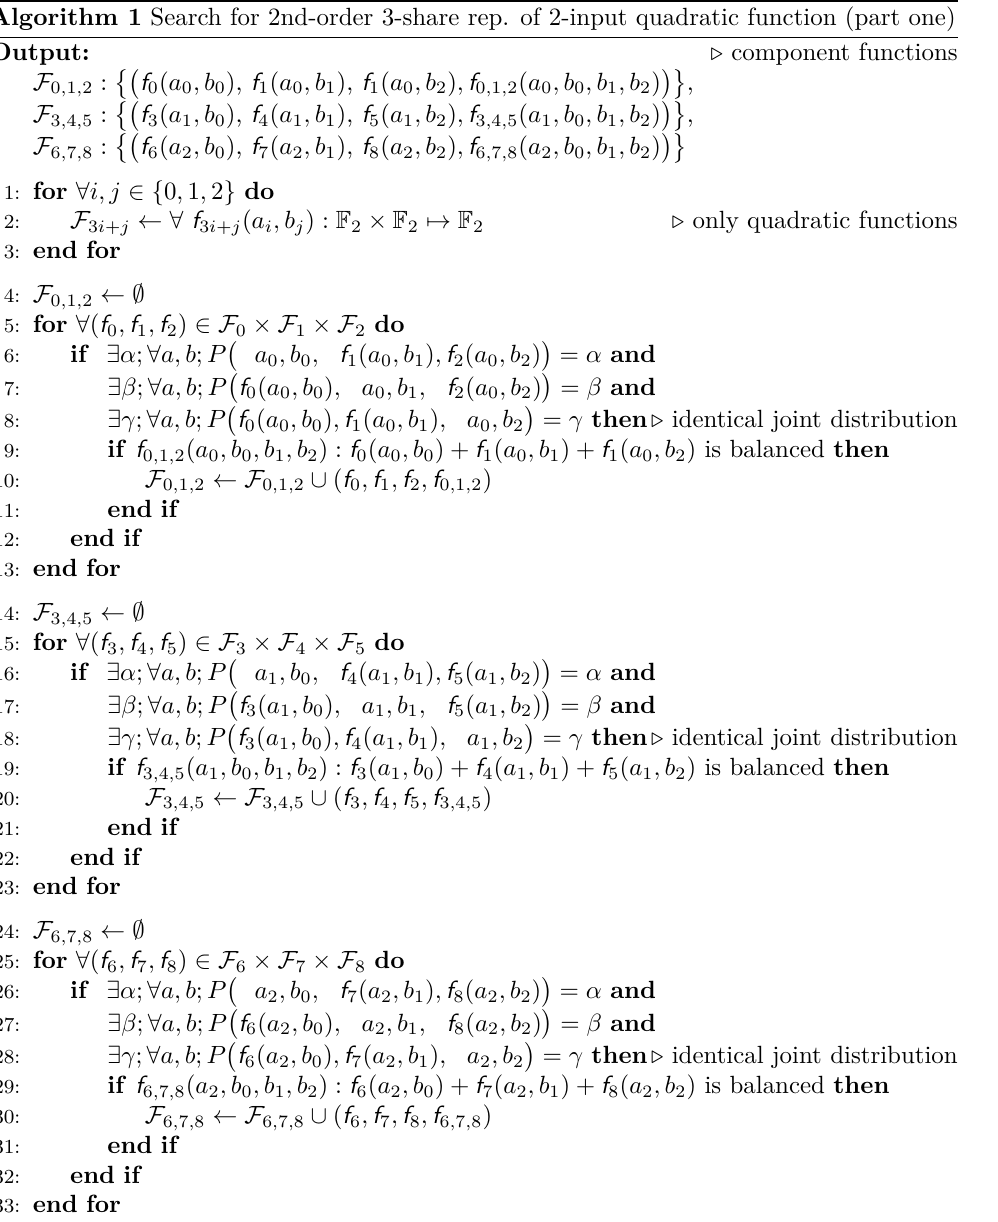
Algorithm 1 Search for 2nd-order 3-share rep. of 2-input quadratic function (part one) Output: . component